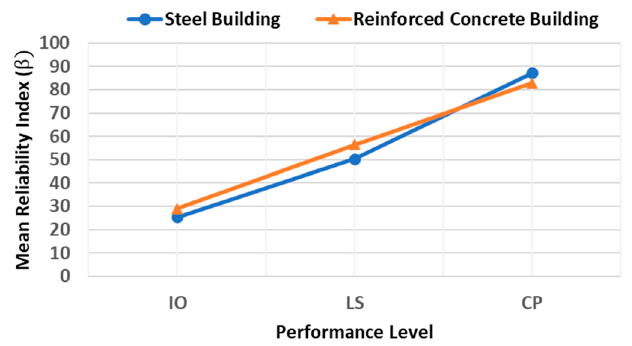
Figure 17. Mean reliability index for steel and reinforced concrete buildings located at Guadalajara, Jalisco (seismic zone C).